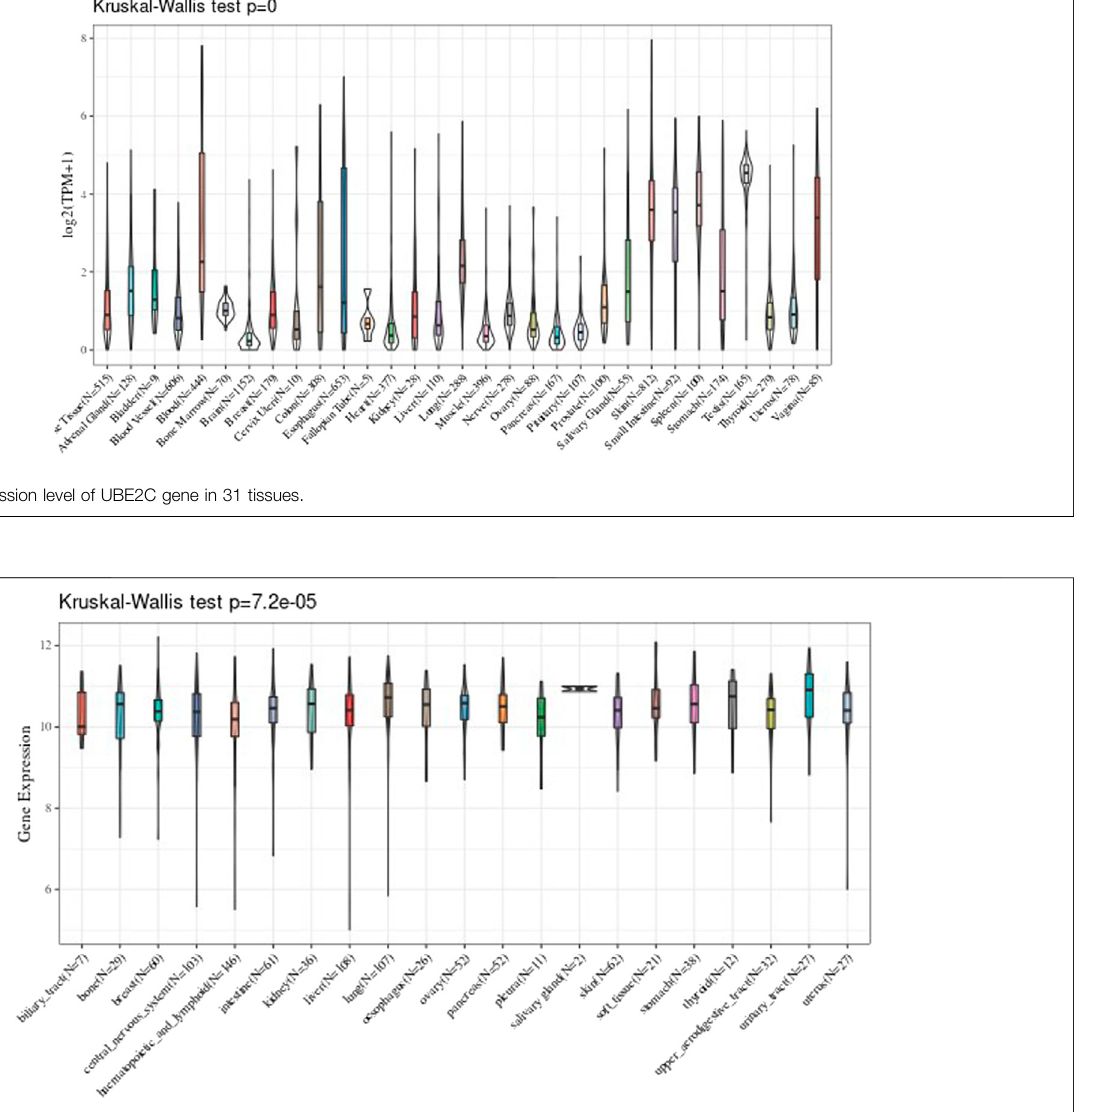
FIGURE 2 | Comparison of the expression value level of UBE2C gene in twenty-one